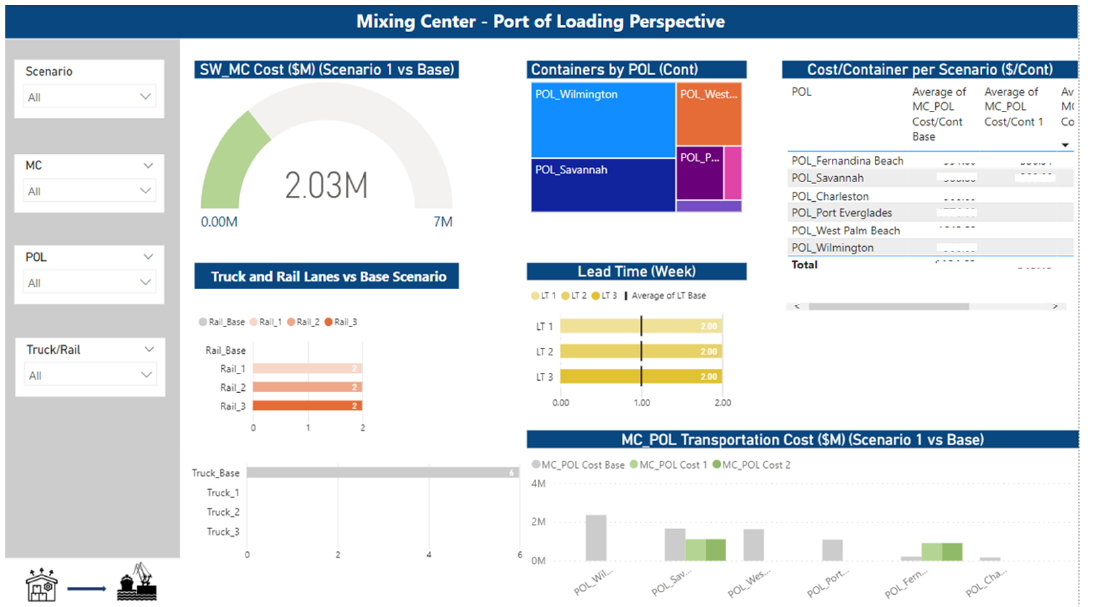
Figure A2. Summary of Supply Warehouse to Mixing Center Perspective. The legend corresponds to the notation introduced in Section 4.3.1. The values for current rates, new contract assumptions, and costs are sensitive data and intentionally covered.